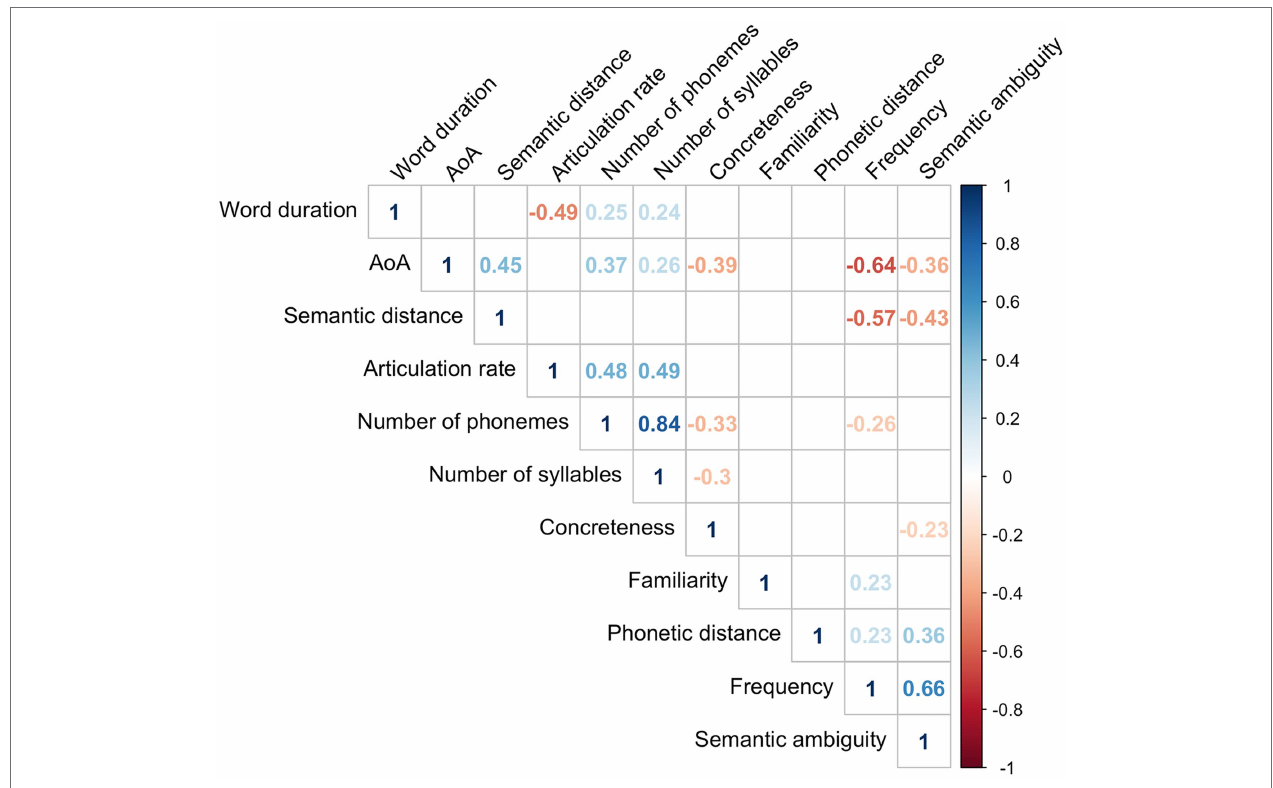
FIGURE 3 | The correlation matrix of the mean values of all variables. Only significant correlations ( p < 0.05) are shown in the